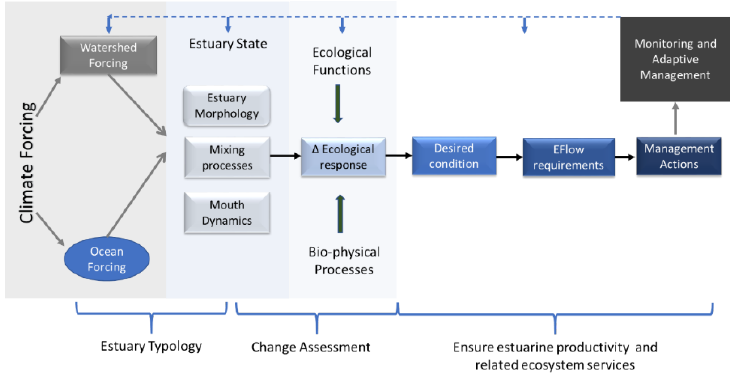
Figure 1. Framework for establishing ecological flow requirements. Key research gaps exist for understanding how climate forcing and estuary typology affect ecological functions and inform desired conditions, monitoring and adaptive management.